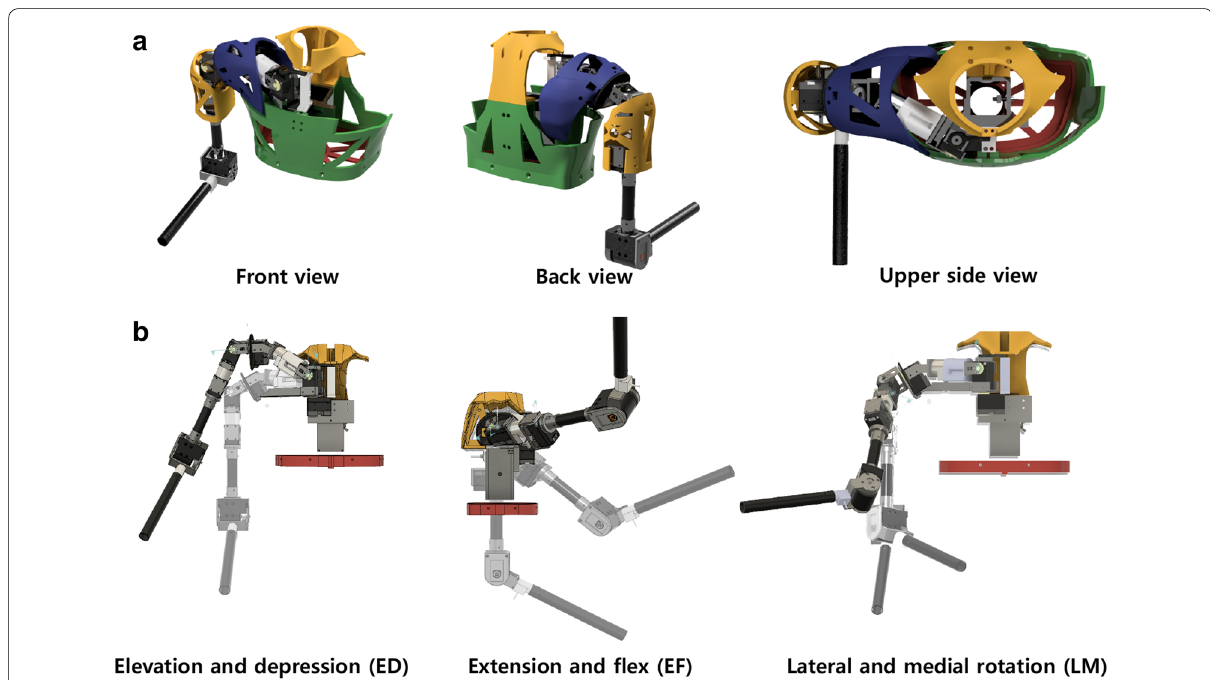
Fig. 2 Upper limb of the care training assistant robot. a 3D modeling views. b Mechanisms of the upper limb of care training assistant